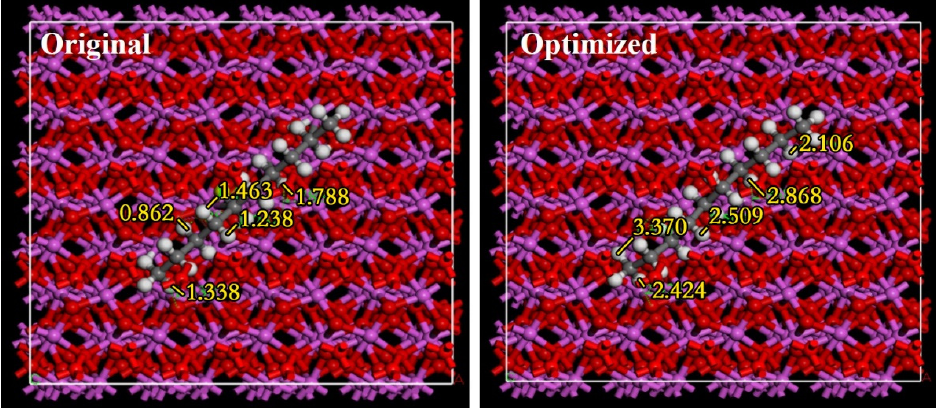
Figure 3. Original and optimized molecular structure of paraffin adsorbed on Al 2 O 3.